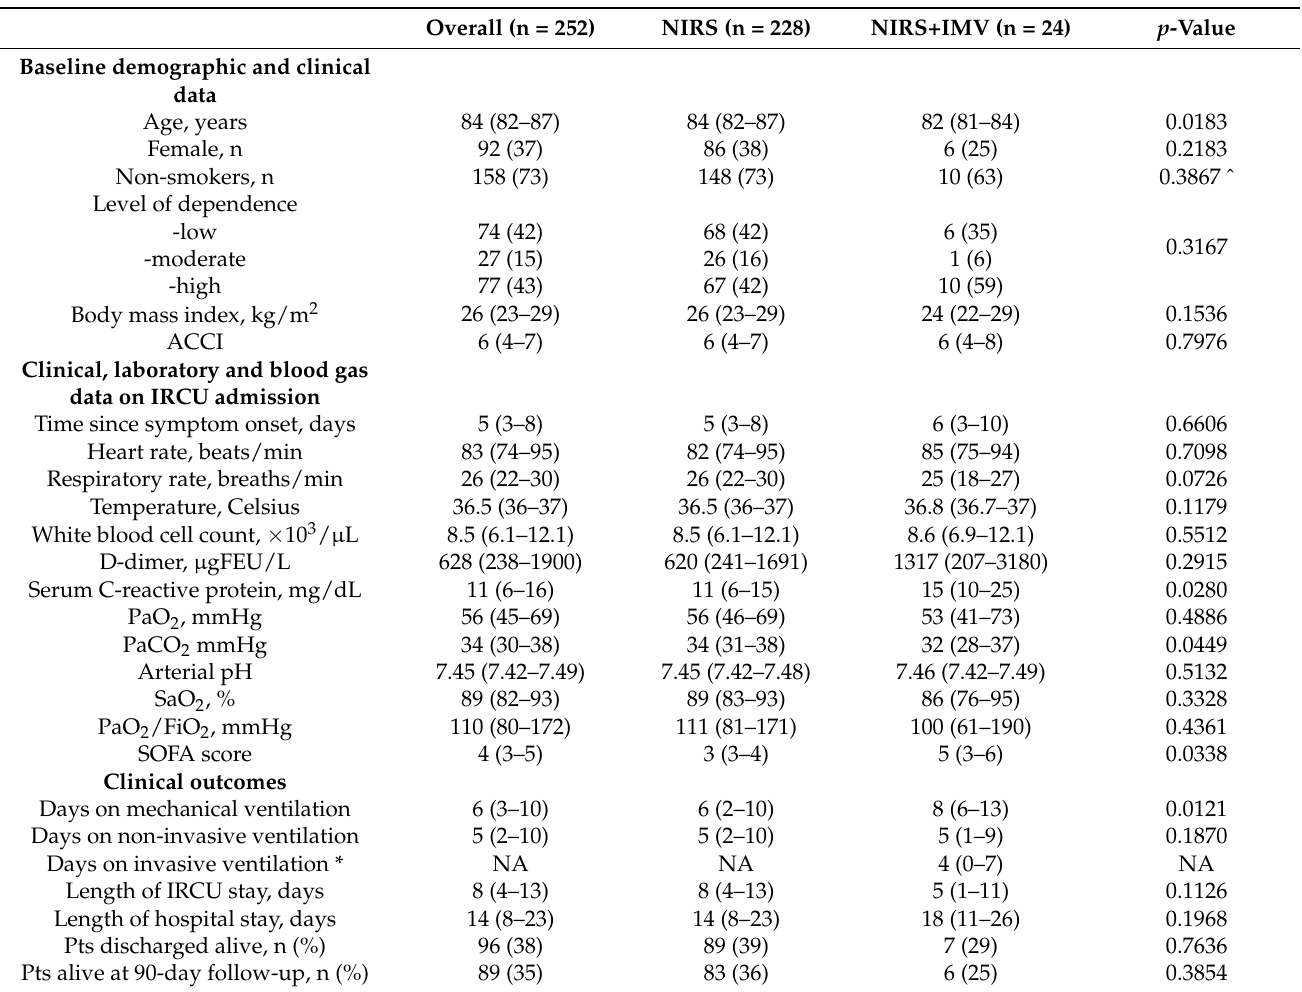
Table 1. Patients’ baseline demographic and clinical characteristics, clinical and laboratory data on Intermediate Respiratory Care Unit admission, and clinical